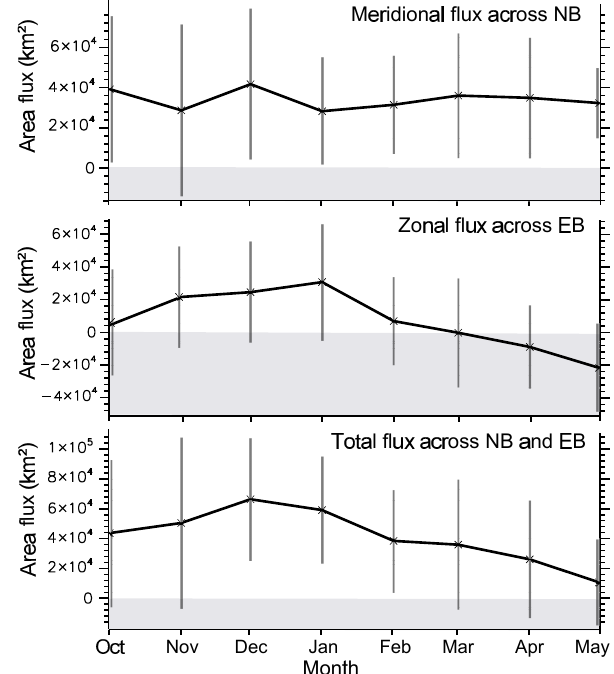
Fig. 5. Seasonal cycle of average monthly meridional ice area flux across northern boundary (upper panel), zonal flux across eastern boundary (center panel) and total flux (lower panel, given in 10 4 km 2 ) for the period between 1992 and 2011. Bars denote SE . Grey shaded areas correspond to ice inflow (negative flux).